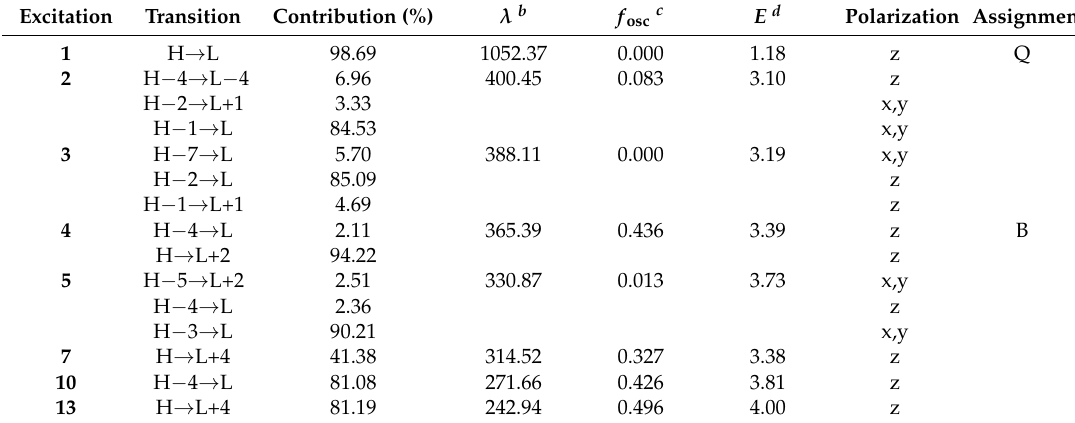
Table 2. Properties of the main electronic transitions of neutral unsubstituted (16)norcorrole ( 16N ) a . Excitation